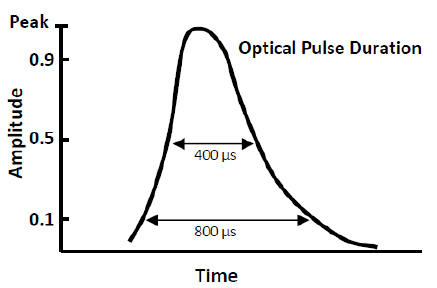
Figuer5. Typical lightning optical pulse profile